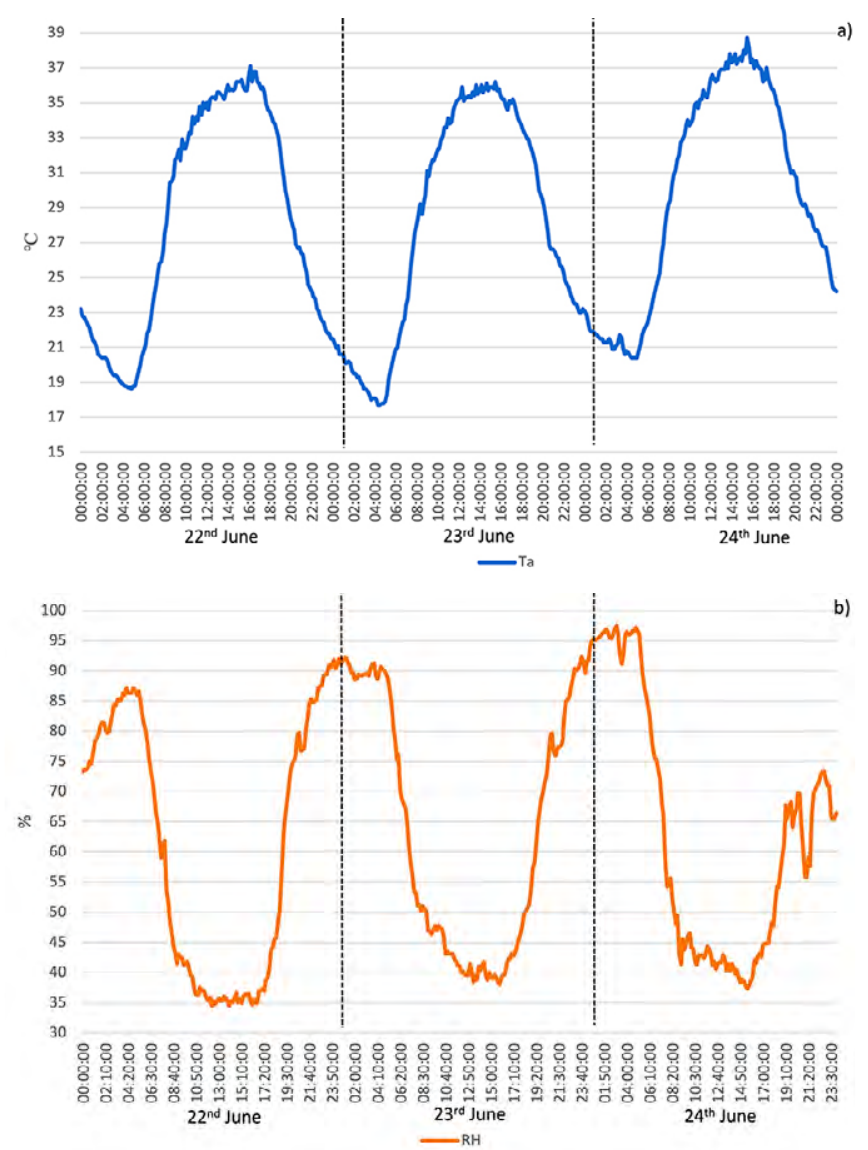
Figure 3. Weather conditions in Banja Luka (Bosnia and Herzegovina) in the period 22-24 June 2021: a) T